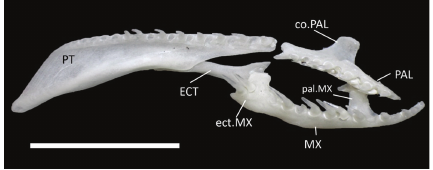
Figure 12: Ventral view of the palatomaxillary complex of Sordel- lina punctata (IBSP 49404). Bar = 5 mm. Abbreviations other than in previous figures are ect.MX: ectopterygoid process of maxilla.